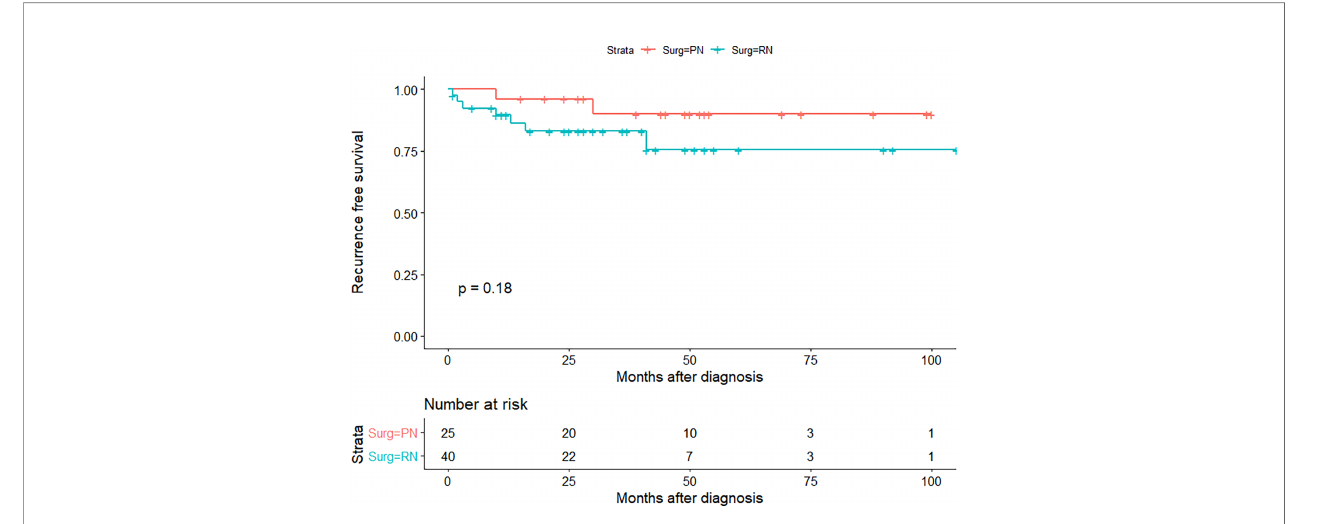
FIGURE 4 | Recurrence-free survival (RFS) curve of partial nephrectomy (PN) and radical nephrectomy (RN) group in Tongji Hospital (TJH) cohort.